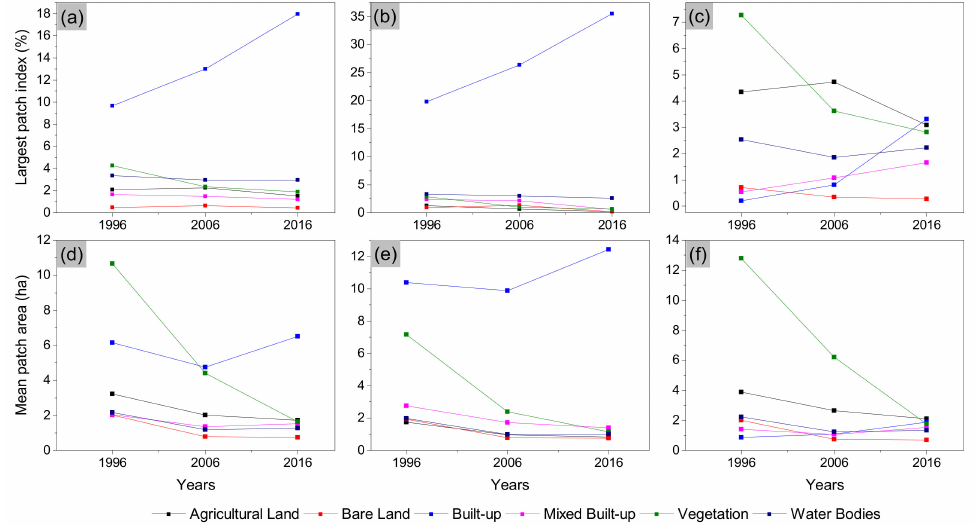
Figure 10. Class level LPI and AREA_MN; ( a – c ) show class level LPI for the LULCs over KMA, KMA-urban, and KMA-rural, respectively, in 1996, 2006, and 2016; and ( d – f ) reflects class level temporal trend in AREA_MN over KMA, KMA-urban, and KMA-rural, respectively, in 1996, 2006, and